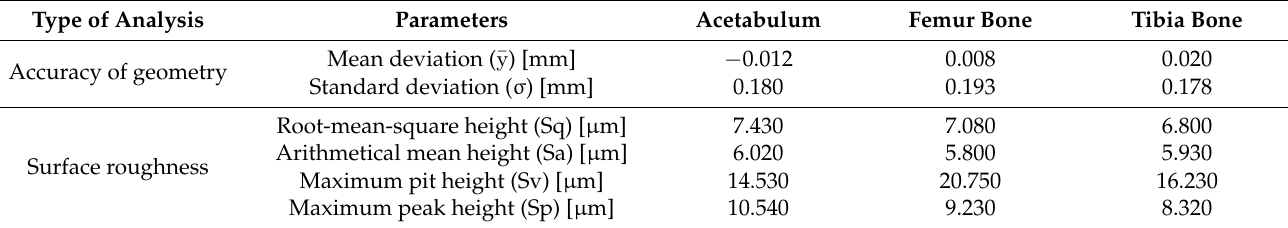
Table 10. Statistical parameters—without using a procedure.